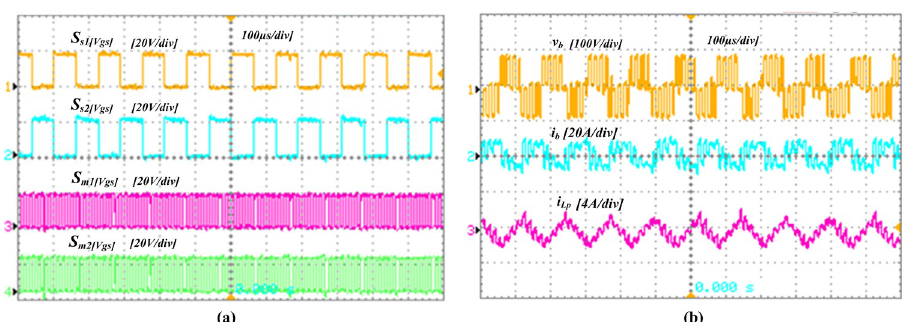
, S , S and a1 (V gs ) a2 (V gs ) m1 (V gs )